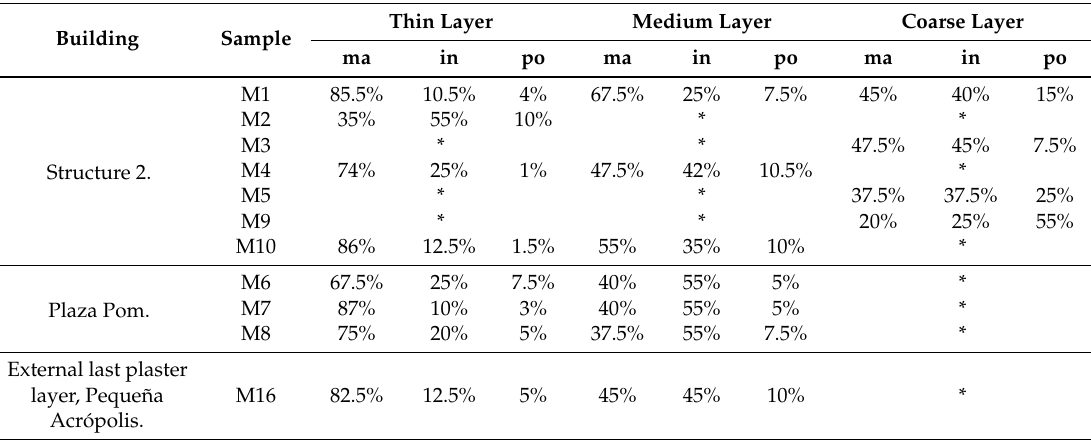
Table 3. Proportions in the Type 1 plasters; the data are based on the percentage of matrix (ma), inclusions (in) and pores (po) in each layer: in every group of three percentages, the first corresponds to the percentage of binder, the second to the percentage of inclusions and the third to the percentage of porosity. * represents a layer that could not be sampled either because it was not observed, because the layers that were above were too hard and well preserved, or because the layer was so powdery that it was not possible to sample it.